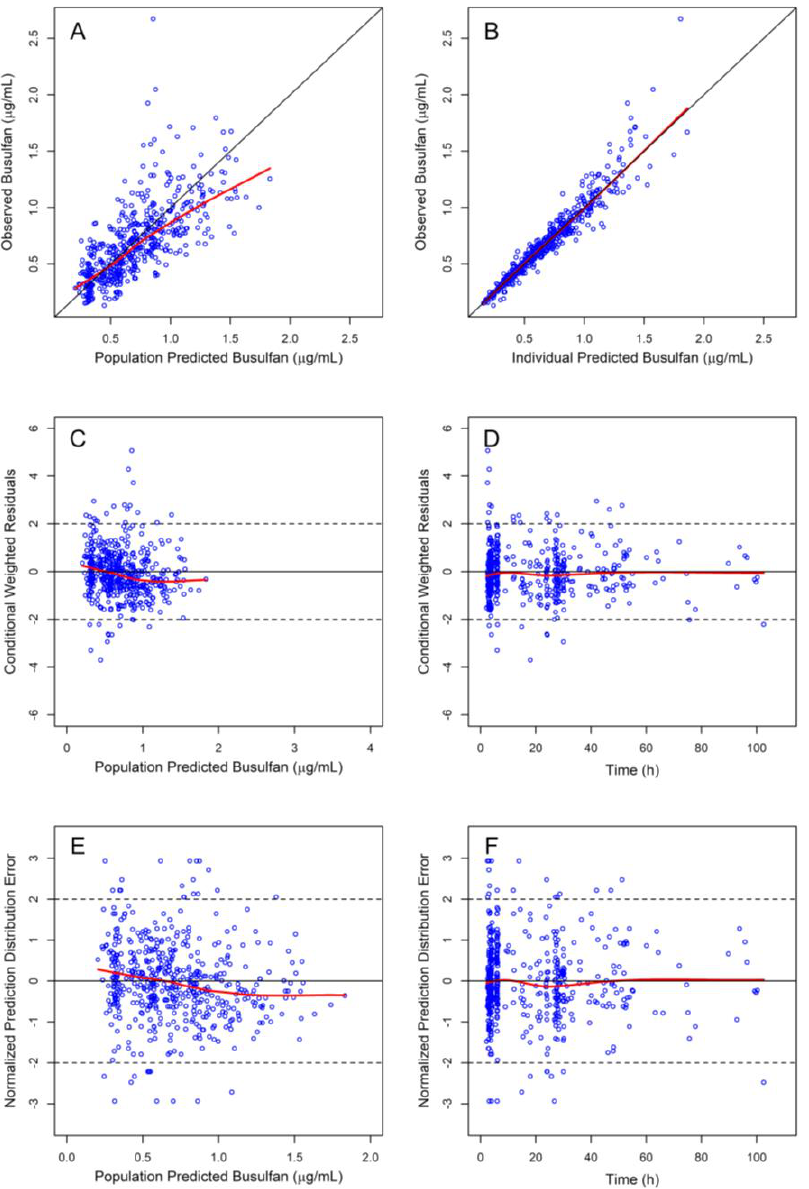
Figure 1. Diagnostic plots for the final PopPK model. Observed vs. population predicted plasma concentrations ( A ) and individual predicted plasma concentrations ( B ) plots (black and red lines represent the identity and cubic spline smooth lines, respectively). Conditional weighted residuals vs. population predicted plasma concentrations ( C ) and vs. TIME ( D ) (solid line y = 0, dashed lines y = 2 and y = − 2). Normalized Prediction Distribution Error vs. population predicted plasma concentrations ( E ) and vs. Time ( F ).